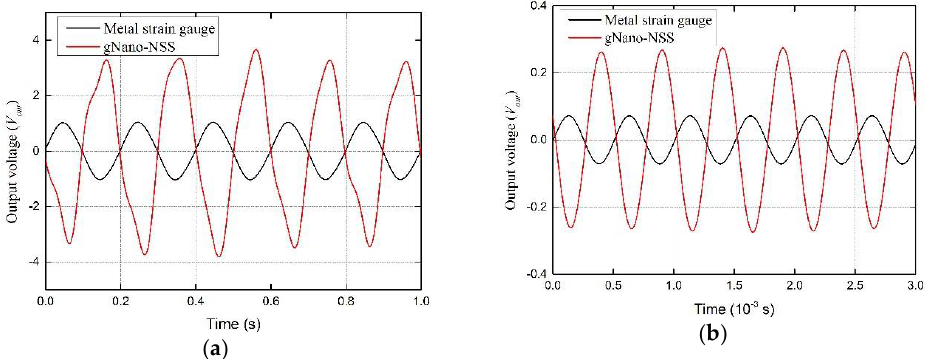
Figure 10. Vibration signals of metal strain gauge and gNano-NSS at ( a ) 5 Hz and ( b ) 2 kHz.